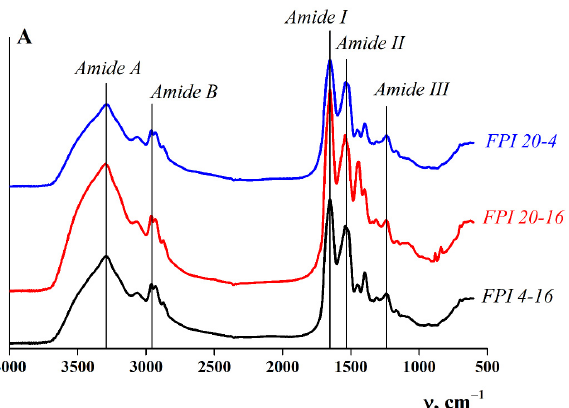
Figure 1. FT-IR spectra of fish protein isolates (FPIs) obtained under various conditions of alkaline solubilisation. FPI sample designations are given next to the spectra. An alkaline environment can cause changes in the secondary, tertiary and quaternary structure of proteins and their agglomerates [14]. At high pH values, protein macromol- cules unfold due to an increase in the mutual repulsion forces in the polypeptide chains, so their hydrophobic and free sulphydryl (–SH) groups become available for an interac- tion. In addition, the reactivity of some amino acid residues, such as cysteine, increases in an alkaline environment, which leads to the involvement of cysteines in thiol–disulphide exchange reactions. Strong intermolecular interactions affect the secondary structure of the protein by changing the ratio between different conformational states of the protein molecule regions: β -turns, β -sheets, random coils and α -helices [30]. The amide I band is known to be the most sensitive to these changes. To obtain the quantitative information, we decomposed the amide I band into several components using a Gaussian distribution using the OriginPro 9.0 graphics program (Fig- ure 2). The quantitative contribution of the macromolecular chains in different confor- mations was determined as the ratio of the integrated intensity of the corresponding band to the integrated intensity of the amide I band before the decomposition (Table 3). Table 3. Content (%) of the amide I components for fish protein isolates (FPIs) obtained under var- ious conditions of alkaline solubilisation.